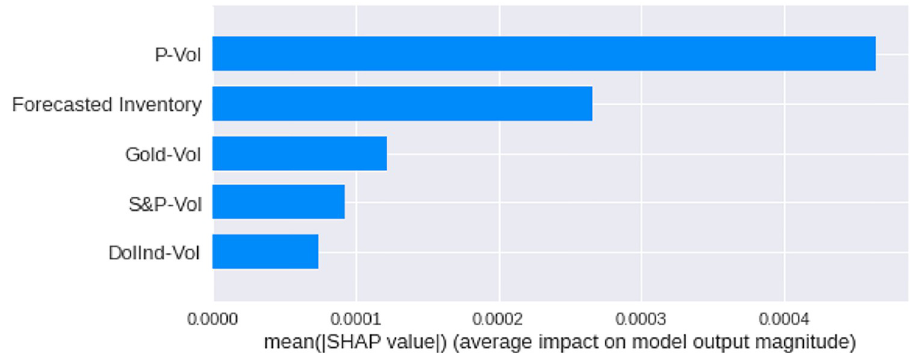
Fig 19. Mean Shapley values for the first previous day using Nadam optimizer.